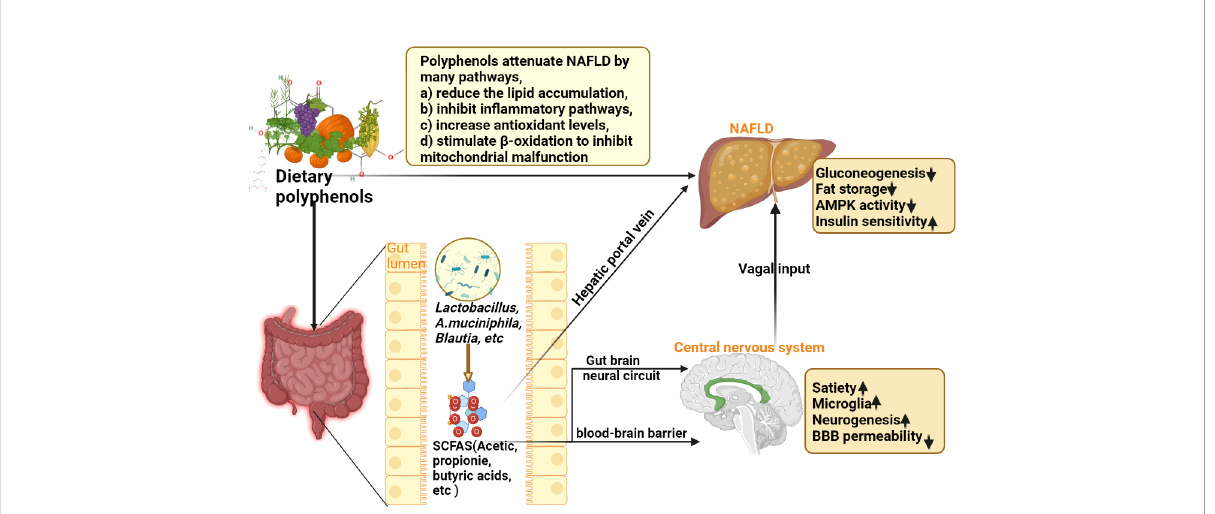
FIGURE 7 Schematic diagram of the mechanism of dietary polyphenols in the treatment of NAFLD (SCFAS, short-chain fatty acids; NAFLD, non-alcoholic fatty liver